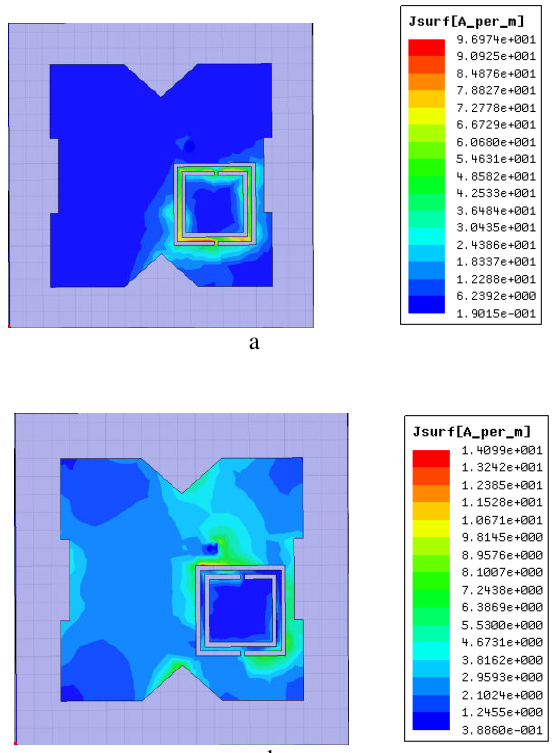
Figure 7: Simulated Surface current distribution at a 2.4 GHz b 3.3